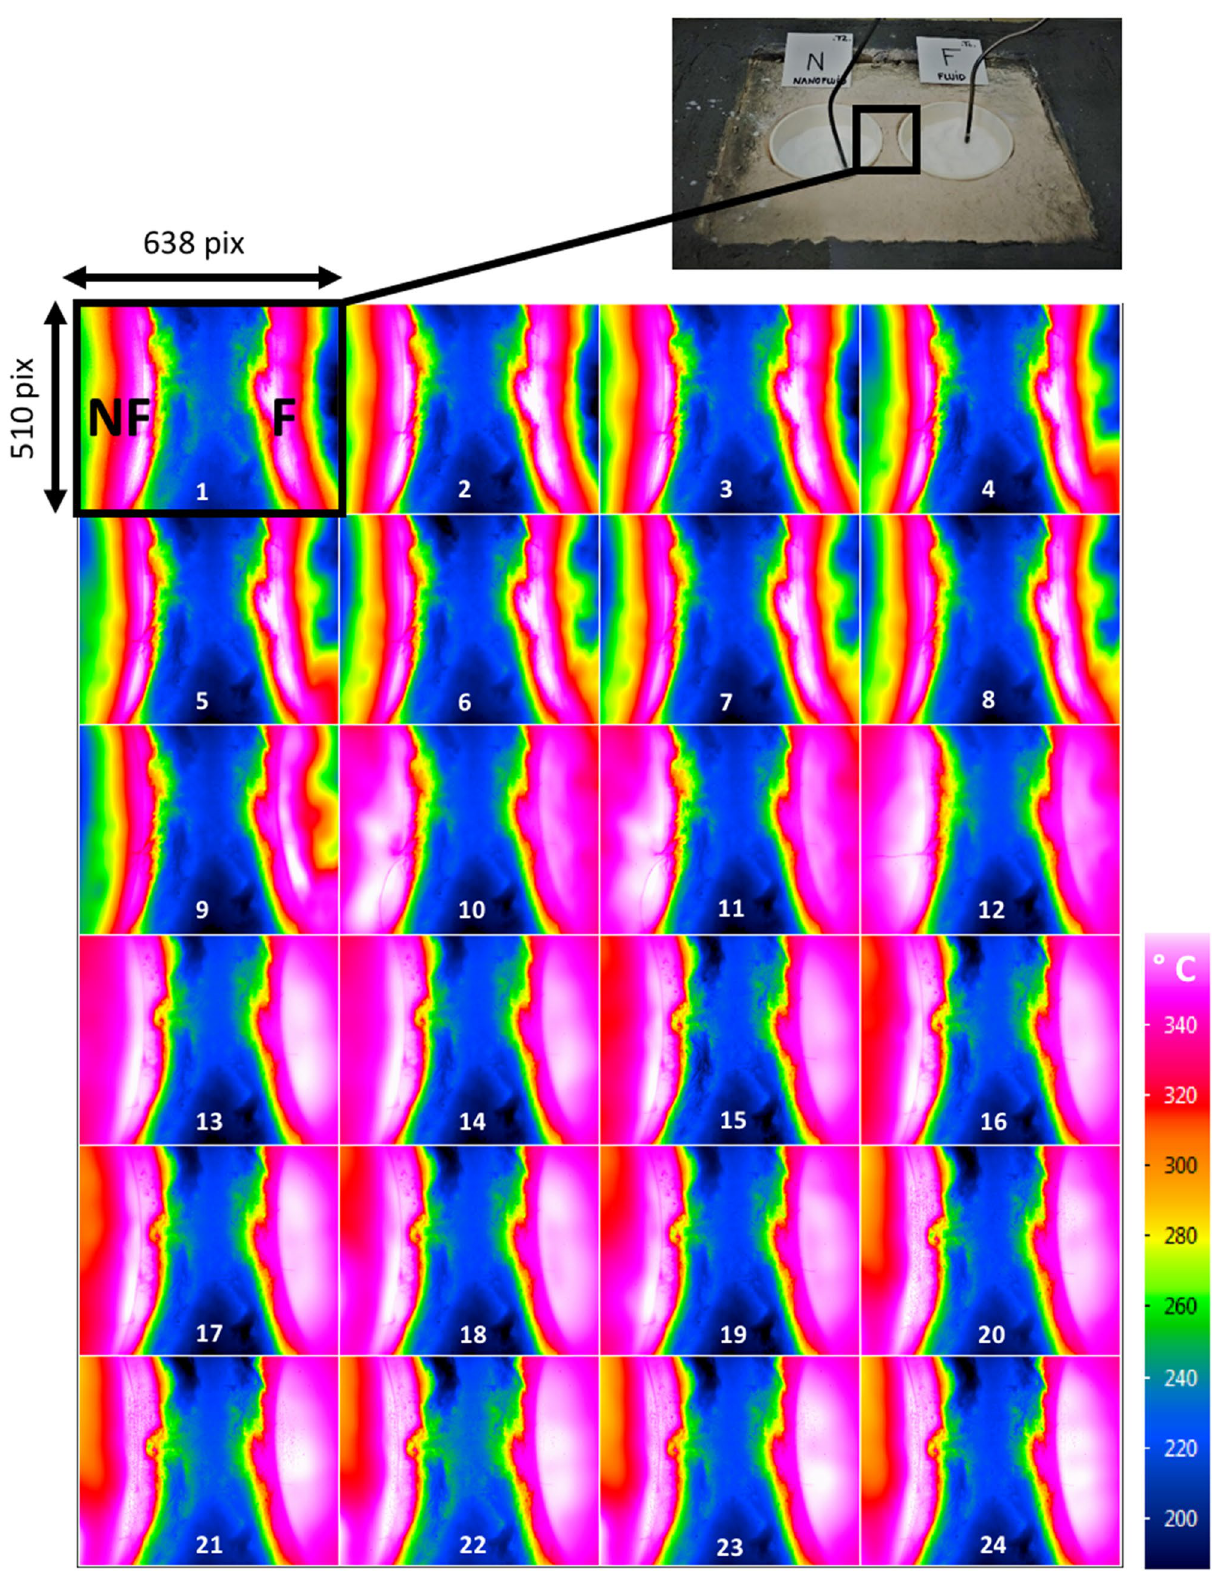
Figure 1. Infrared thermographies during the heating process of the nanofluid sample, NF (left, NaNO 3 + 1 wt% SiO 2 ) and the fluid sample F (right, NaNO 3 ). The electrical power communicated to both samples is the same along the